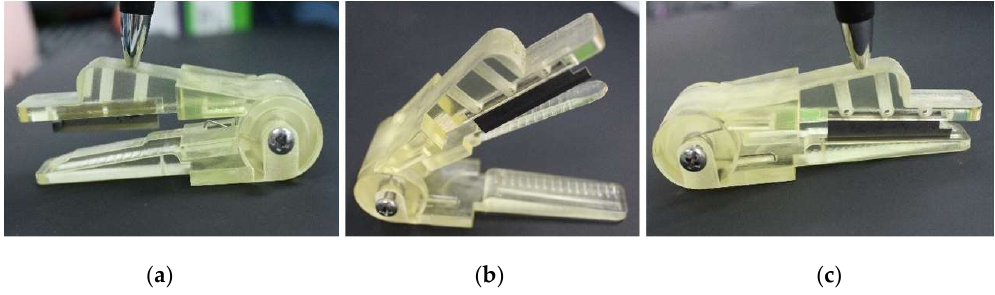
Figure 3. Cutting process: ( a ) rest position; ( b ) clamping state; ( c ) cutting state.